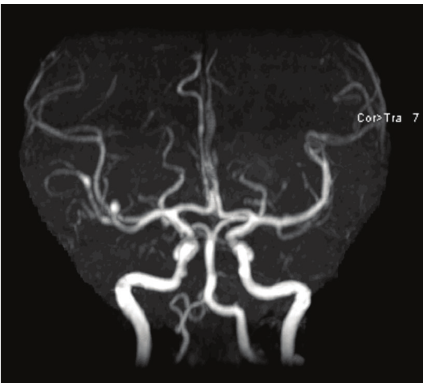
Figure 7: 24-hour post-Onyx embolization MRA scan in AP view demonstrating resolution of the embolized MCA aneurysm.